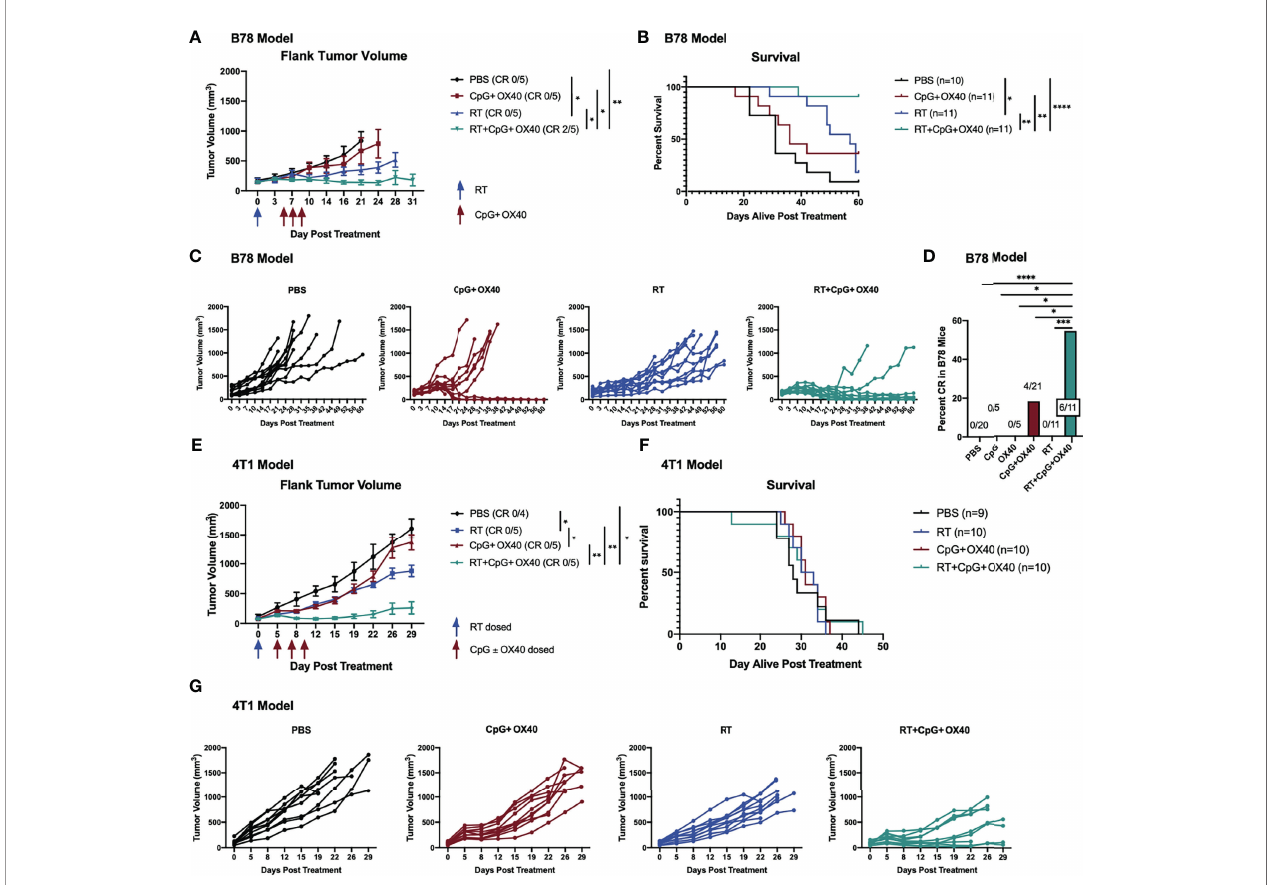
FIGURE 3 | RT Enhances the Local Anti-Tumor Effect of CpG+OX40 in Multiple Tumor Models. (A) Average tumor volume plots (+/- standard error of the mean) from a representative experiment, and (B) combined overall survival from two independent experiments in the B78 model showing group responses to PBS (black), CpG+OX40 (red), RT (blue), and RT+CpG+OX40 (teal) along with the number of mice that demonstrated a complete response (CR) to treatment. (C) Combined individual tumor volume plots from two independent experiments showing each mouse ’ s response to various treatments shown in (B) . (D) Number of B78 tumor- bearing mice showing a complete response for the summary of 4 experiments (shown in Figure 1F and Figure 2B ) (E) Average tumor volume plots (+/- standard error of the mean) from a representative experiment, and (F) combined overall survival from two independent experiments in the 4T1 model showing group responses to PBS (black), CpG+OX40 (red), RT (blue), and RT+CpG+OX40 (teal) along with the number of mice that demonstrated a complete response to treatment. (G) Combined individual tumor volume plots from two independent experiments showing each mouse ’ s response to various treatments for the mice shown in (E) Red arrows shown in (A, E) indicate the days CpG and/or OX40 were dosed IT (d. 5, 7, 9), while blue arrows shown in (A, E) indicate if/when RT was dosed (d. 0). In both models, n=4-6 per group per experiment. P values for average tumor volume plots calculated using time-weighted average analysis. P values for overall survival calculated via log rank test. *P ≤ 0.05; **P ≤ 0.01; ***P ≤ 0.001; ****P ≤